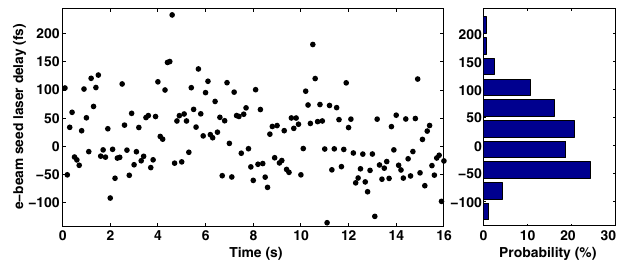
FIG. 6 (color online). (a) Evolution of the centroid of the hole produced by the seeding on a sequence of 200 consecutive electron bunches. (b) Distribution of the centroid positions characterized by an rms of 68